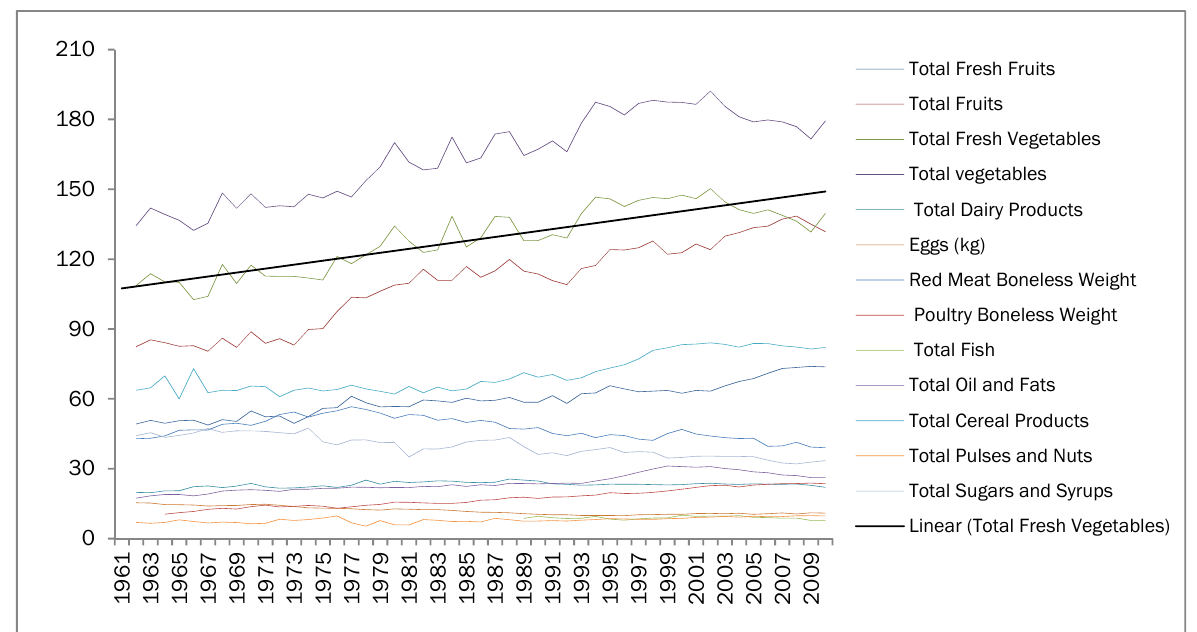
Note: Data on fish have only been available since 1988. Source: Data from Statistics Canada with calculation by the